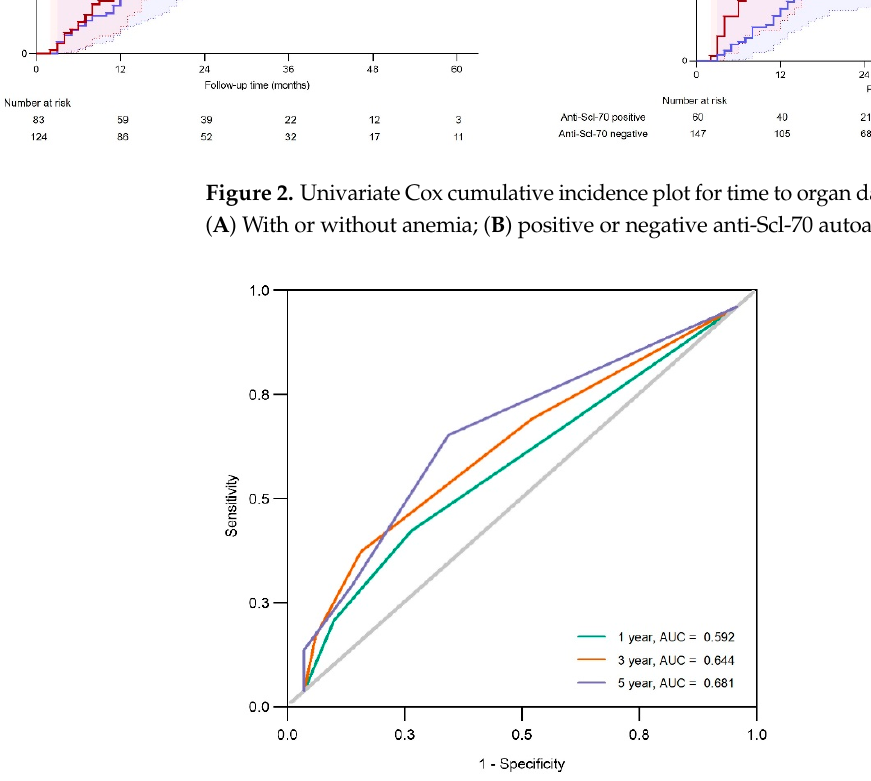
Figure 3. Time-dependent ROC curves for the final prediction model of organ damage progression. The final prediction model included anemia at the initial visit and positive anti-Scl-70 autoantibody. AUC, area under the curve.